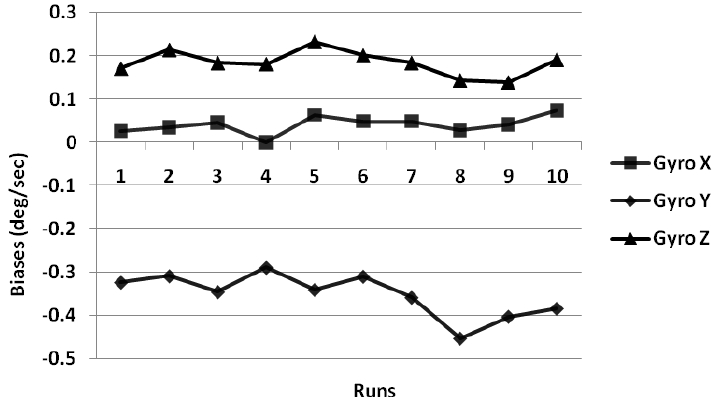
Figure 1. Gyroscope turn-on to turn-on biases.